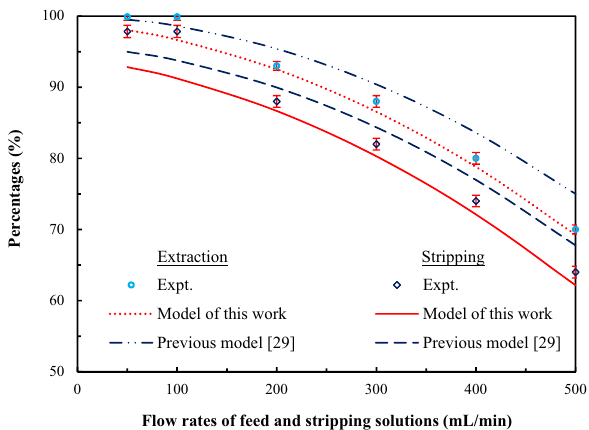
Figure 8. Percentages of extraction and stripping of arsenic ions against flow rates of feed and strippant solutions via HFSLM having 0.68 M Aliquat 336 dissolved in toluene as the liquid membrane, at pH 12 of feed solution, using a mixture of HCl and thiourea (0.5 M each) as the strippant solution; standard deviations for %extraction = ± 0.6 and for %stripping = ± 0.8.